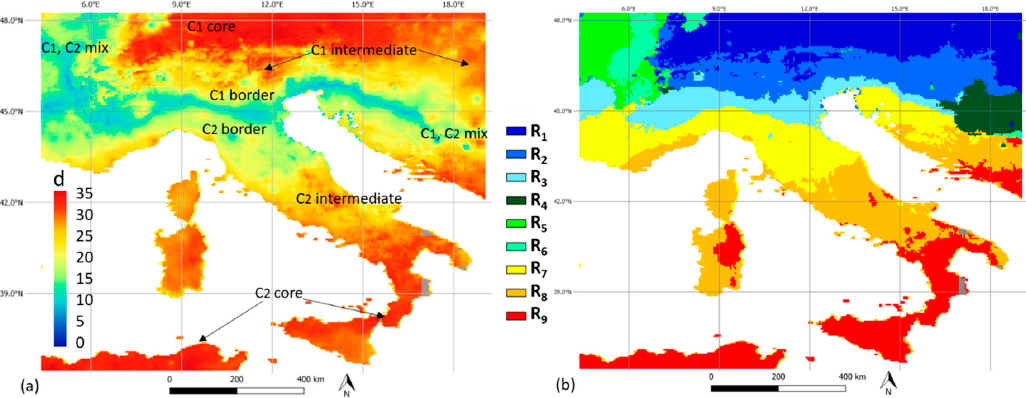
Figure 6. Seasonal clusters: ( a ) distances d between each pixel in C1 k = 2 from the centroid of C2 k = 2 and vice versa; ( b ) results from the K-means algorithm applied with K =